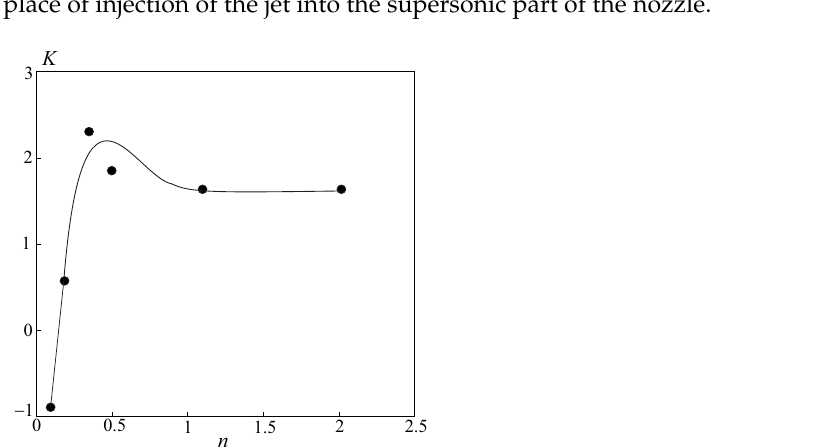
Figure 18. Dependance of the thrust on the pressure ratio.